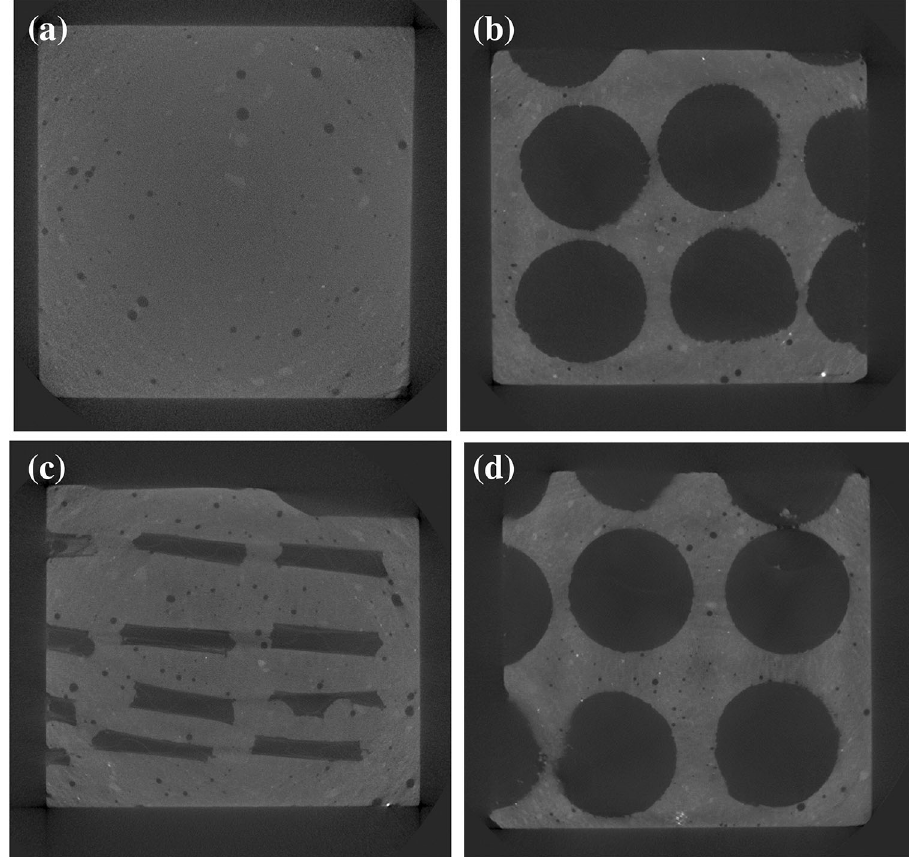
Fig. 10 X-ray CT images of the insulating specimens with coin-shaped insulations: a Reference, b Rubber specimen, c Side view of Paper specimen, d EPS specimen ( Note In these figure, only a quarter of the section image is visualized due to the limitation of image